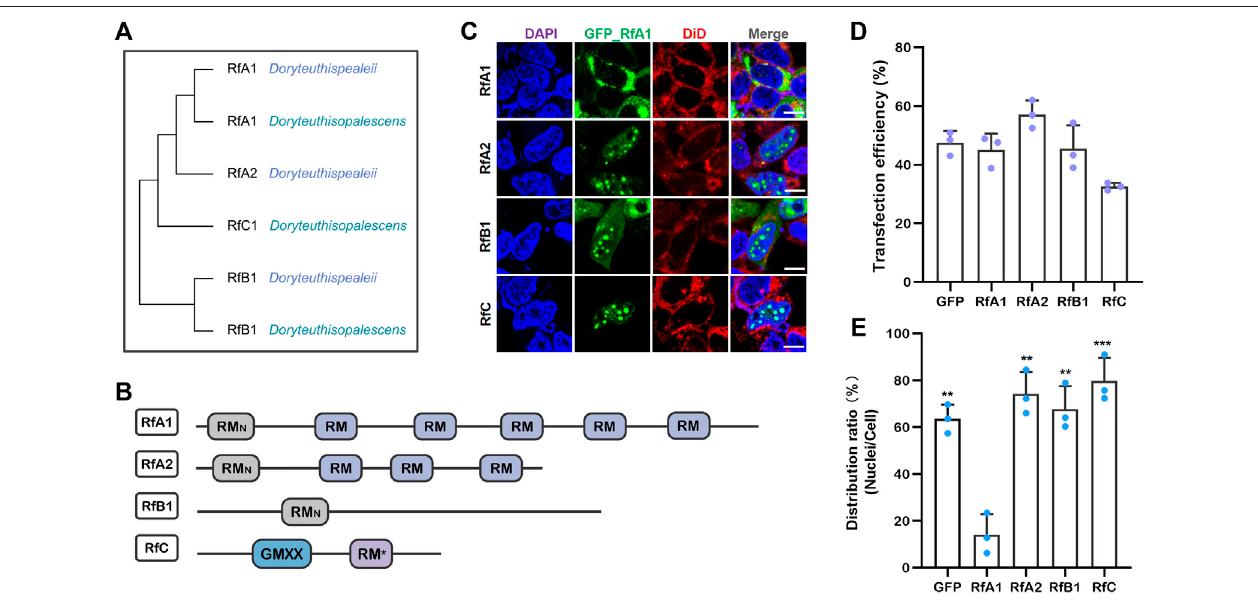
FIGURE 1 | Transfection of re fl ectins induces protein condensate formation in selective intracellular regions. (A) Cladogram of RfA1, RfA2, RfB1, and RfC. (B) Schematicre fl ectinssequences.Re fl ectinmotifsaredesignatedbyboxes,whilere fl ectinlinkers(RLs)arelines. (C) ConfocalimagesofGFP_Re fl ectincondensatesinthe HEK-293T cells. Nuclei and membrane are stained with DAPI (blue) and DiD (red) respectively, scale bars = 10 μ M. (D) Cell number statistics and quanti fi cation of transfection ef fi ciencies of four re fl ectins. (E) Distribution ratio statistics of fl uorescent intensity in transfected cells and their nuclei. Data are presented as mean values ± SD, for n = 3 independent experiments. p -values (from a two-sided unpaired t test): p , p < 0.05; pp , p < 0.01; ppp , p < 0.001; all groups are compared to RfA1.